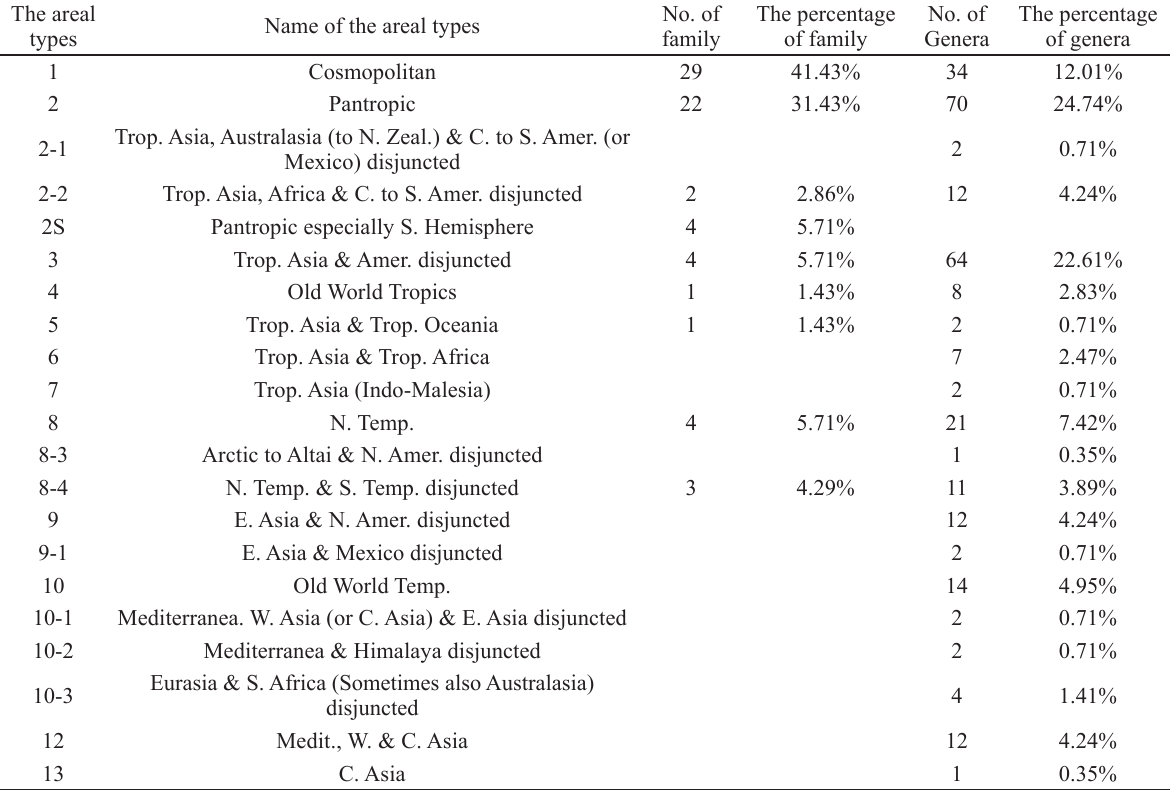
The areal types of aiSPS in China.